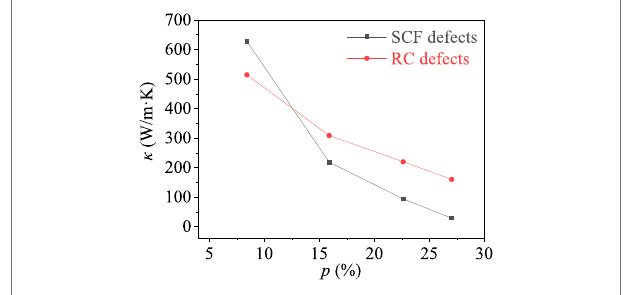
FIGURE 2 | TC of two defective graphene.